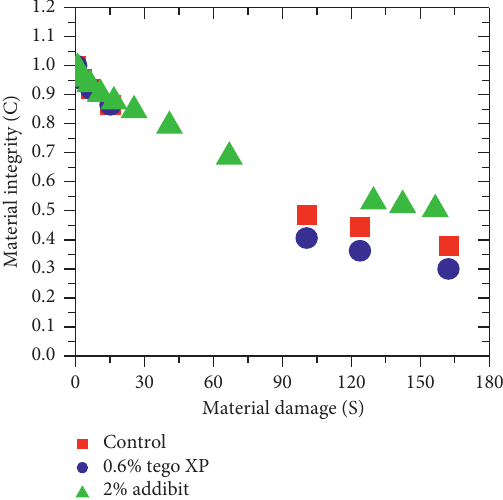
Figure 9: (a) VECD damage